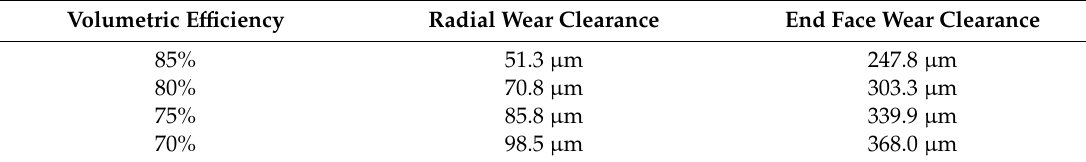
Table 2. Degradation state of wear clearance of sample pump.